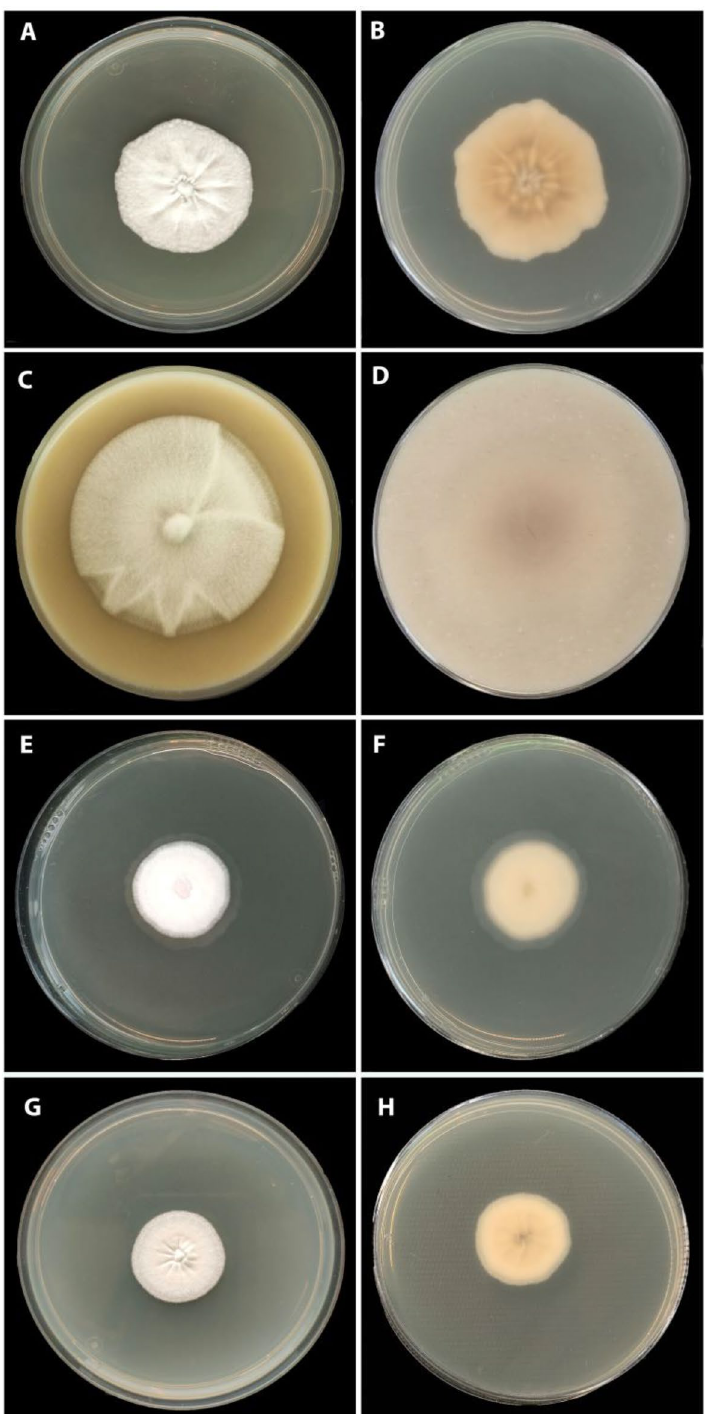
Fig. 1 Colonies of Induratia apiospora (ATCC 60639) after four weeks A , B on MEA; C , D on OA; E , F on PDA; G , H on